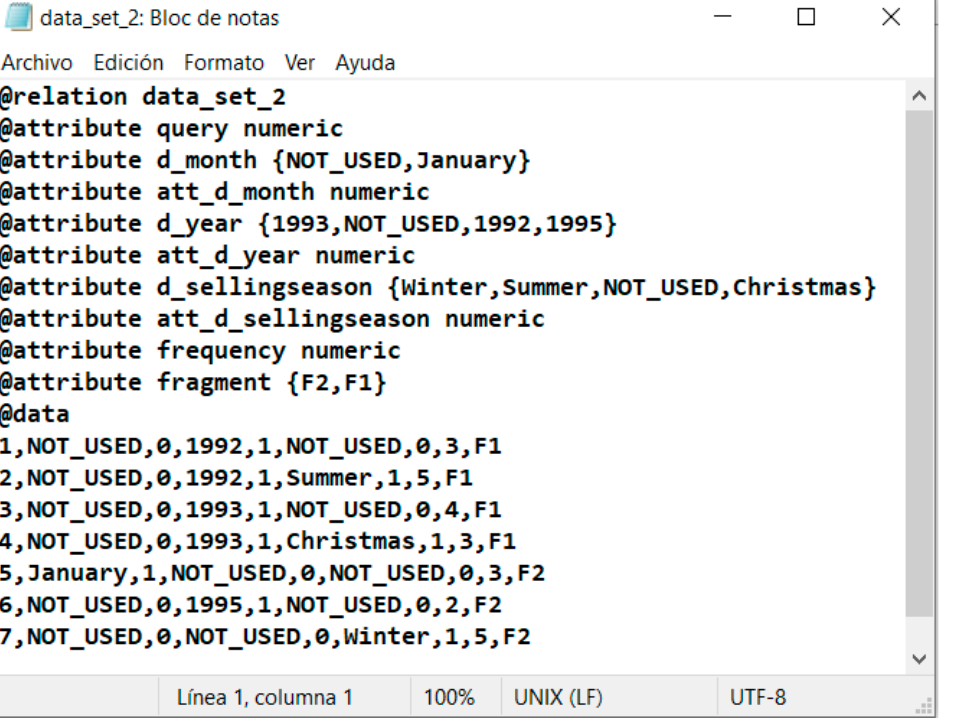
Figure 2. Data set for step 6 of the PT.